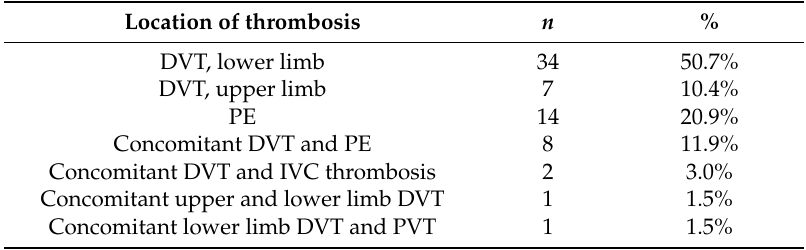
Table 2. Distribution of venous thromboembolism in our study group ( n = 67).